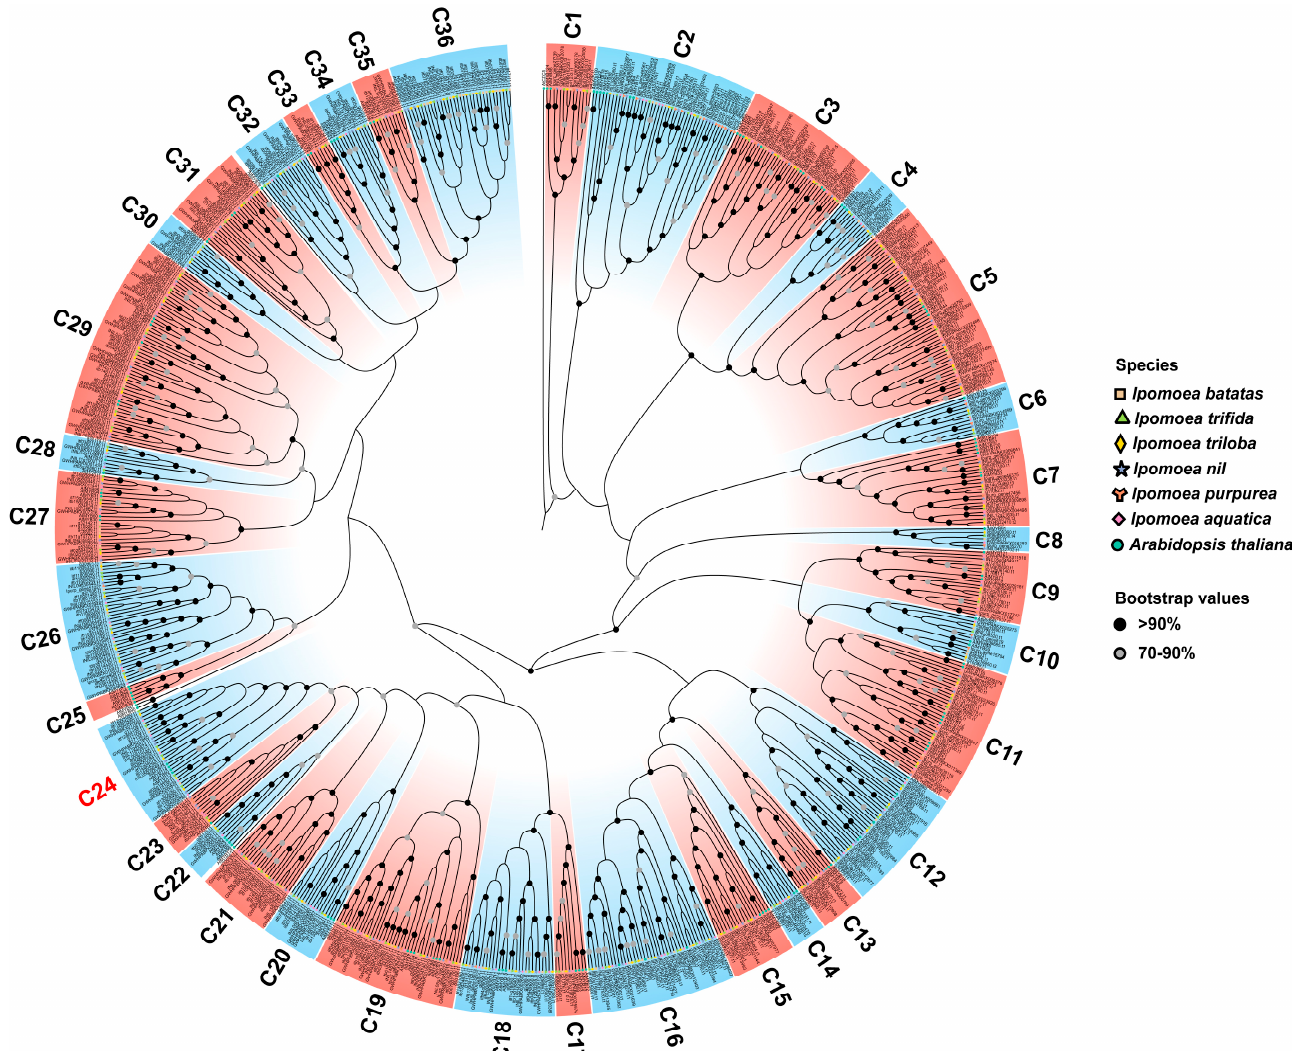
Figure 2. Phylogenetic tree of R2R3-MYB members in Arabidopsis and six Ipomoea species. All identified R2R3-MYB members from I. batatas (131), I. trifida (133), I. triloba (129), I. nil (127), I. purpurea (51), I. aquatica (124), and Arabidopsis (126) were used. The full-length amino acid sequences of R2R3-MYB proteins were aligned using MAFFT, and the tree was constructed by the maximum-likelihood (ML) method of IQ-tree using the JTT + F + R10 model. These R2R3-MYB proteins are clustered into 36 clades (designated as C1 to C36). The AtCDC5 was rooted as the outgroup, and 4 proteins did not fit well into the clade. The genes that belonged to the same organism were marked in the same shape and color. The dots on the branches represent bootstrap values based on 1000 replications, and bootstrap values >90% and ≥ 70% are shown as black and gray dots in the phylogenetic tree, respectively, while those <70% are not